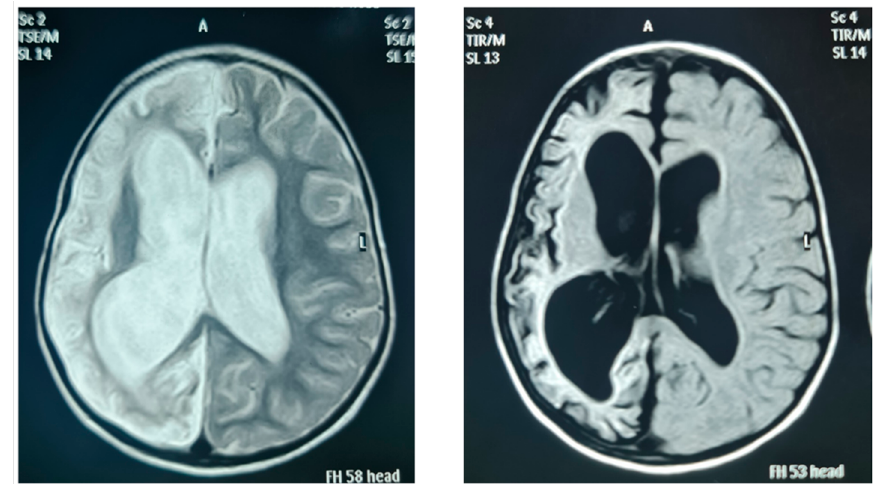
Figure 2. Brain MRI of patient